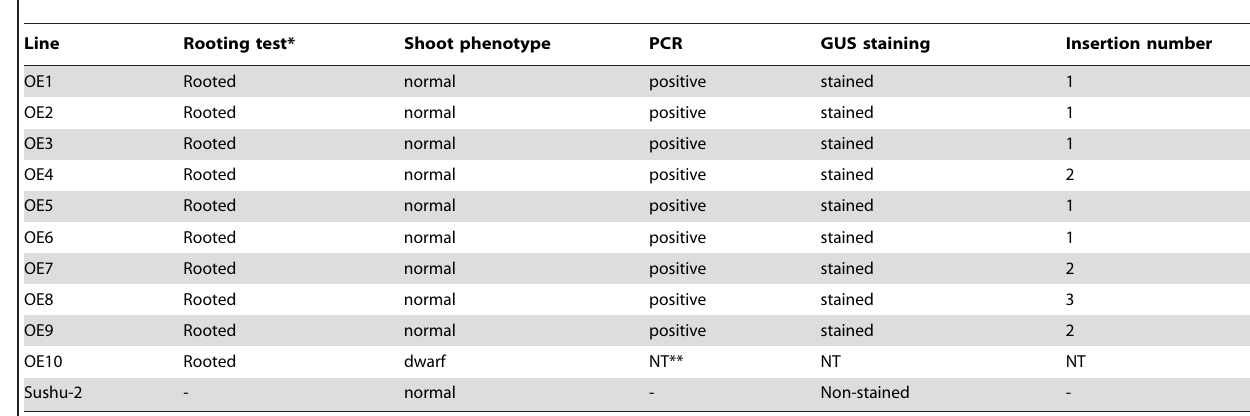
Table 1. Phenotypic and primary molecular screening of the transgenic sweet potato lines from transformed cultivar Sushu-2.